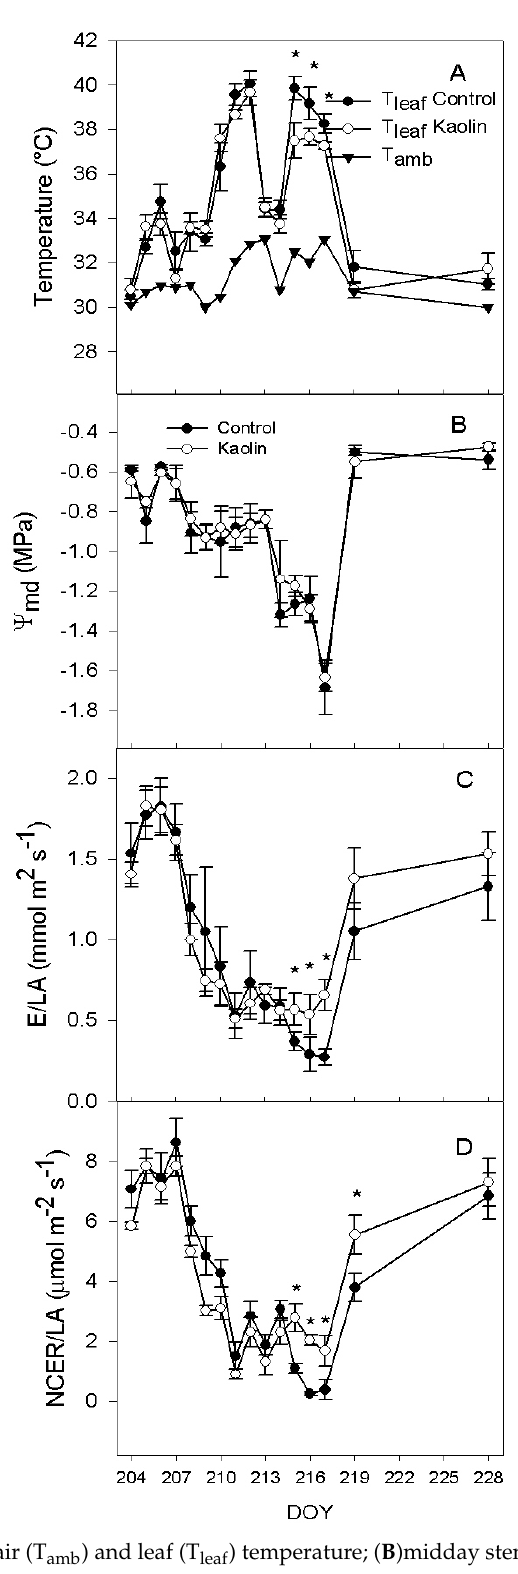
Figure 1. ( A )Trends for air (T amb ) and leaf (T leaf ) temperature; ( B )midday stem water potential ( Ψ MD ); ( C ) whole-canopy transpiration (E / LA) and ( D ) specific whole-canopy net CO 2 exchange rate / leaf area (NCER / LA), according to a progressive water shortage (DOY 209–217) and subsequent re-watering (at DOY 218), in vines subjected to the kaolin treatment and in controls. Bars represents standard error (SE), n = 3. Asterisks indicate dates within which di ff erences among treatment were significant ( p < 0.05). DOY: day of the